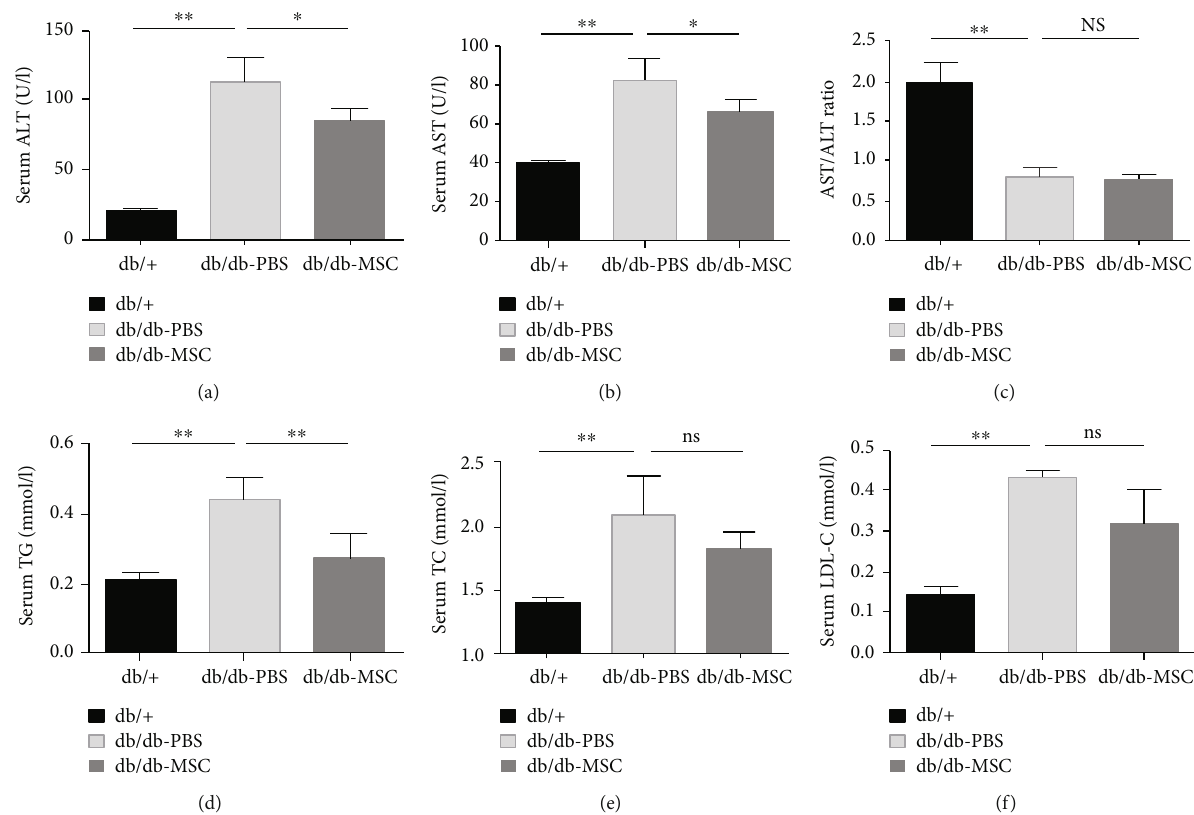
Figure 3: Human UC-MSC infusions relieved functional hepatic injury and improved lipid pro fi les. db/db mice were infused with human UC-MSCs or PBS once a week for six weeks. One week after the infusions, serum concentrations of ALT (a), AST (b), AST/ALT ratio (c), TG (d), TC (e), and LDL-C (f) in the indicated groups were measured. All data are represented as means ± SD . n = 6 mice per group. ∗